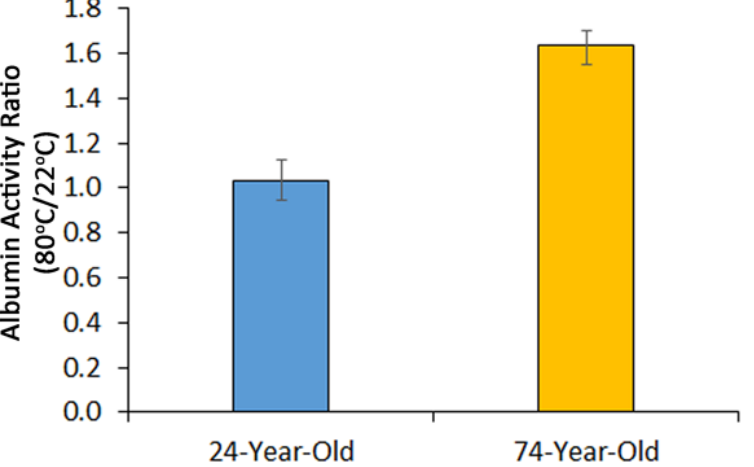
Figure 2. Albumin activity ratio. From the results of Figure 1, the albumin activity of serum sample treated at 80 °C was divided by the albumin activity of the same serum sample treated at 22 °C. The bar represents mean ± SEM of 12 samples, p < 0.0001. The value of Column 24-Year-Old is 1.035 ± 0.088, and the value of Column 74-Year-Old is 1.634 ± 0.065.